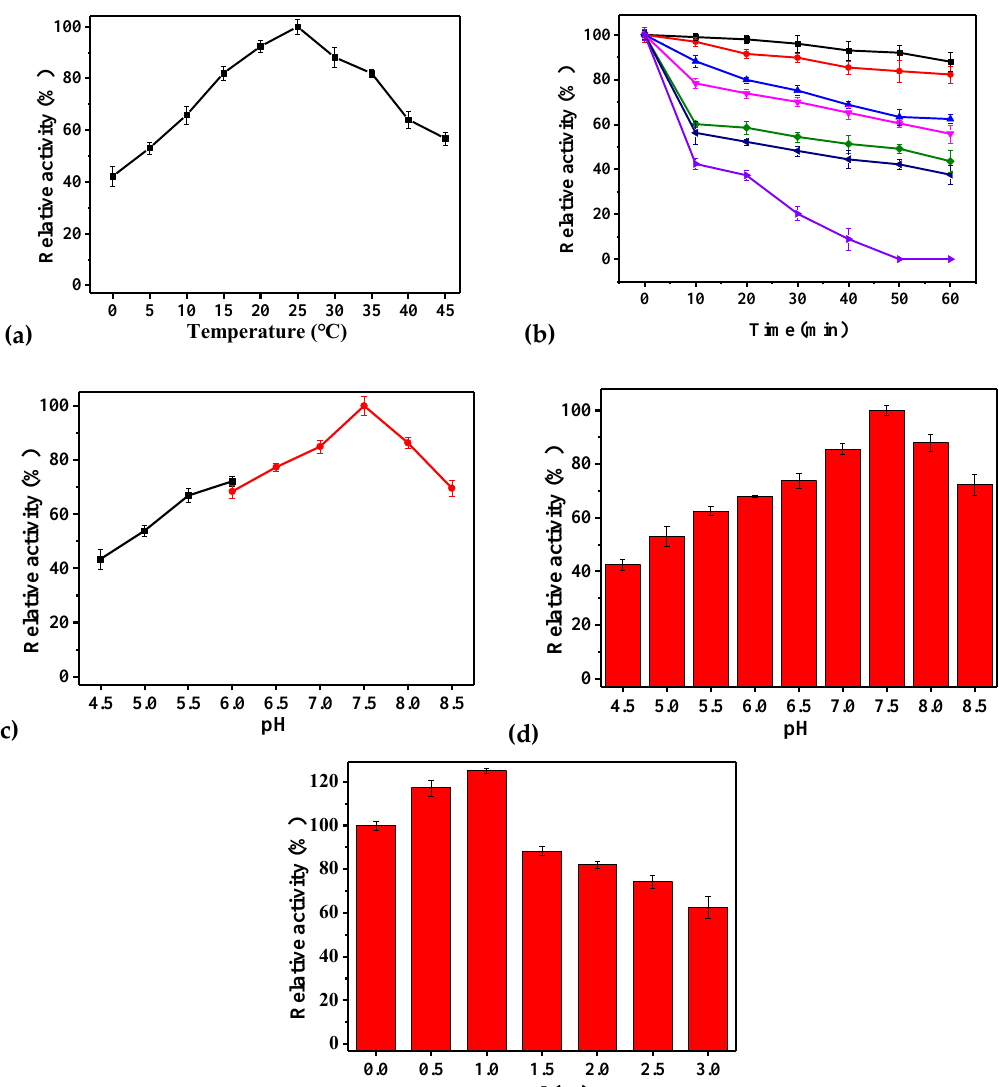
Figure 4. Biochemical characteristics of rPsGR. ( a ) The optimal temperature was determined by measuring the activity at temperatures from 0 to 45 °C. ( b ) Effect of temperatures on the stability of the purified rPsGR. The enzyme was incubated at 25 ( ■ ), 30 (●), 35 ( ▲ ), 40 ( ▼ ), 45 ( ◆ ), 50 ( ◄ ) and 55 °C ( ► ) for 60 min. Its activity relative to time zero was set as 100%. ( c ) The optimal pH was determined by measuring the activity at pH from 4.5 to 8.5. pH buffer contained NaAc/HAc( ■ ) and Na2HPO4/NaH2PO4 (●). ( d ) Effect of pH on the stability of the purified rPsGR. The enzyme was incubated at 30 °C for 30 min. Its maximal activity was taken as 100%. ( e ) The enzyme was incubated by different concentrations of NaCl for 30 min. Its activity with 0 M NaCl was set as 100%. The effect of different additives on rPsGR activity were measured (Table 4). For the purified rPsGR, there was a slight increase in activity with the addition of 0.25 mM MgCl 2 . This increase in activity suggests that Mg 2+ is important to the activity, similar results were obtained for the GR from Chlamydomonas sp. [26]. Furthermore, KCl (0.25 and 1 mM) and CaCl 2 (0.25 mM) slightly inhibited rPsGR activity. K + had also been found to inhibit Setaria cervi GR activity [31]. Additionally, the present of PbCl 2 , CuCl 2 , and HgCl 2 strongly inhibited the activity of rPsGR. The addition of 0.25 mM CuCl 2 to C. vinosum GR inhibited its activity by 33% [30]. The addition of 0.25 mM ZnCl 2 to rPsGR and C. vinosum GR inhibited their activity by approximately 67% and 10% [30], respectively. The GR activity was only 10.9% of the control’s activity after treatment with 0.25 mM HgCl 2 . Pb 2+ and Cu 2+ were found to have significant inhibitory effects on rPsGR. These two metal ions were also found to inhibit the activity of GR from Chlamydomonas sp. [26]. Table 4. Effects of different reagents on the rPsGR activity.